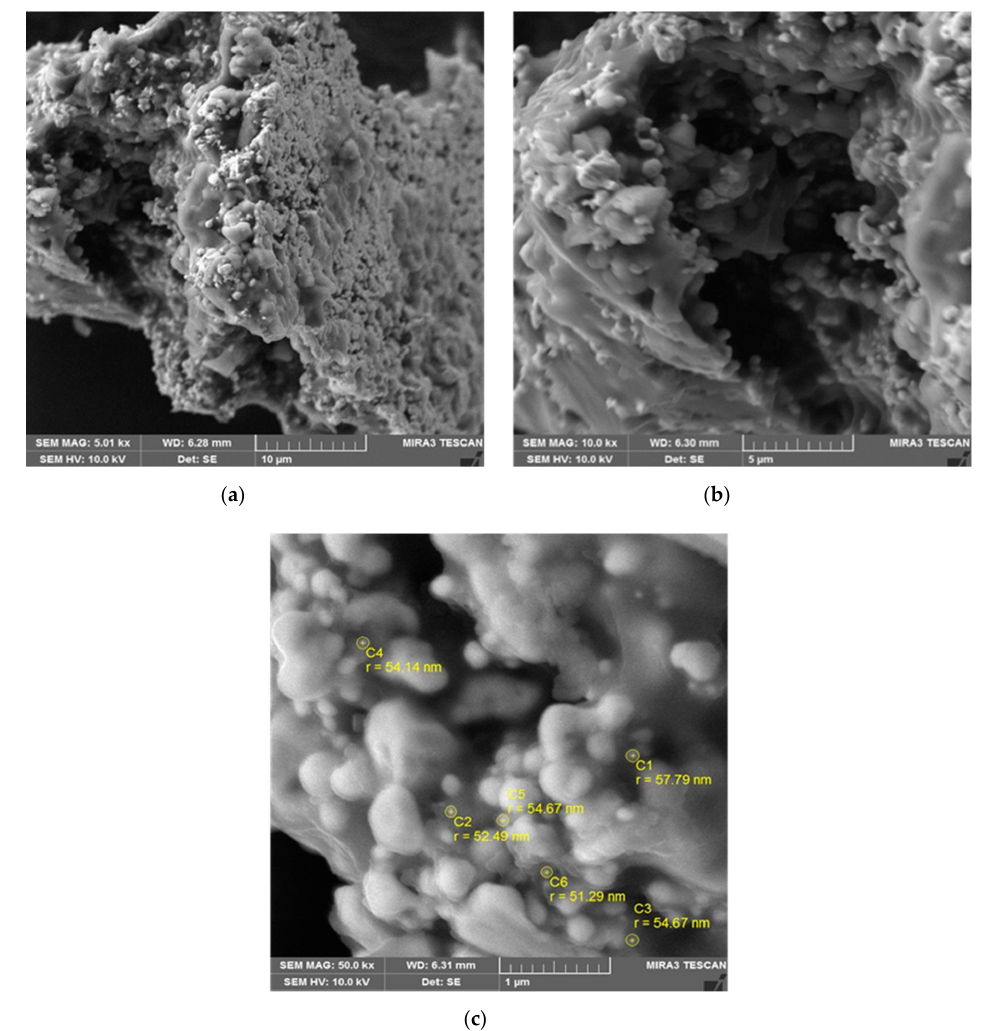
Figure 5. Microstructure of Ag nanoparticles after adding viscosifying solution: ( a ) 5.01 kx, ( b ) 10.0 kx, and ( c ) 50.0 kx.